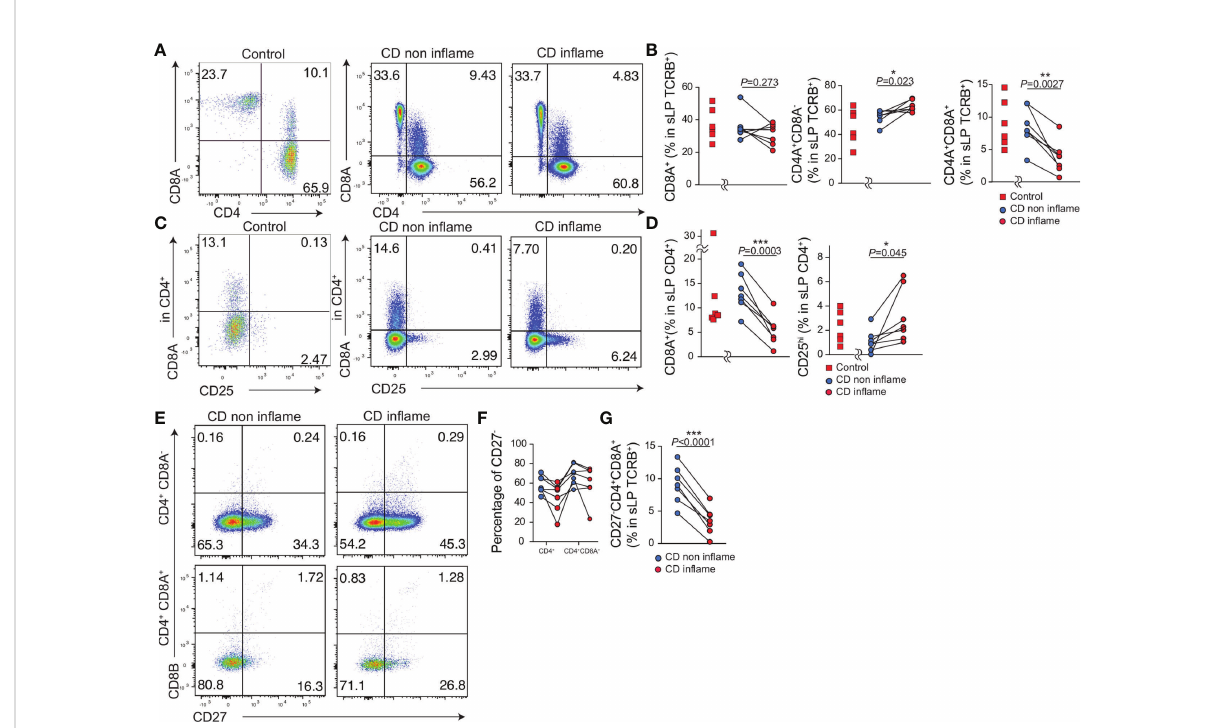
FIGURE 6 The proportion of CD4 + CD8A + T cells in the in fl amed intestine is reduced compared with the non-in fl amed intestine in patients with CD. Intestinal lymphocytes were obtained from the resected small intestine of controls (n=7) and patients with CD (n=7). In fl amed and non-in fl amed tissues were obtained from the same CD patients (CD non in fl ame, CD in fl ame respectively). (A) Representative fl ow cytometry plots of CD4 and CD8A expression by TCRB positive lymphocytes in the small intestine lamina propria (sLPL). (B) Percentage of CD8A + , CD4 + CD8A – , and CD4 + CD8A + cells among the TCRB + lymphocyte subsets in sLPL. (C) Representative fl ow cytometry plots for CD25 and CD8A expression in CD4 + TCRB + T lymphocytes in sLPL. (D) Percentage of CD25 + and CD8A + cells among the CD4 + TCRB + lymphocyte subset in sLPL. (E) Representative fl ow cytometry plots for CD27 and CD8B expression in CD4 + CD8A – TCRB + and CD4 + CD8A + TCRB + T lymphocytes in sLPL. (F) Percentage of CD27 – cells among CD4 + CD8A – TCRB + and CD4 + CD8A + TCRB + T lymphocytes in sLPL. (G) Percentage of CD27 – CD4 + CD8A - cells among the TCRB + T lymphocytes in sLPL. P -values were obtained via the paired Student ’ s t -test. *<0.05, **<0.01, ***<0.001. Each dot represents data from an individual (n =